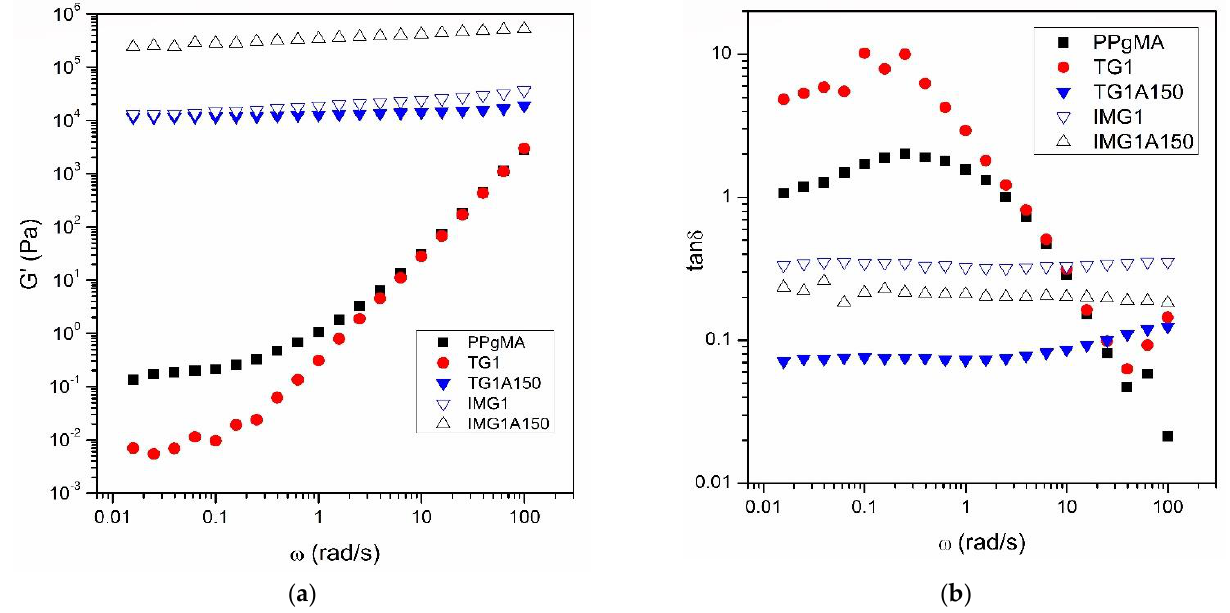
Figure 9. The change in storage modulus ( G′ ) ( a ) and loss tan (tan δ) ( b ) of the cross-linked products at various angular frequency (ω, rad/s) and measured at temperature of 160 °C.